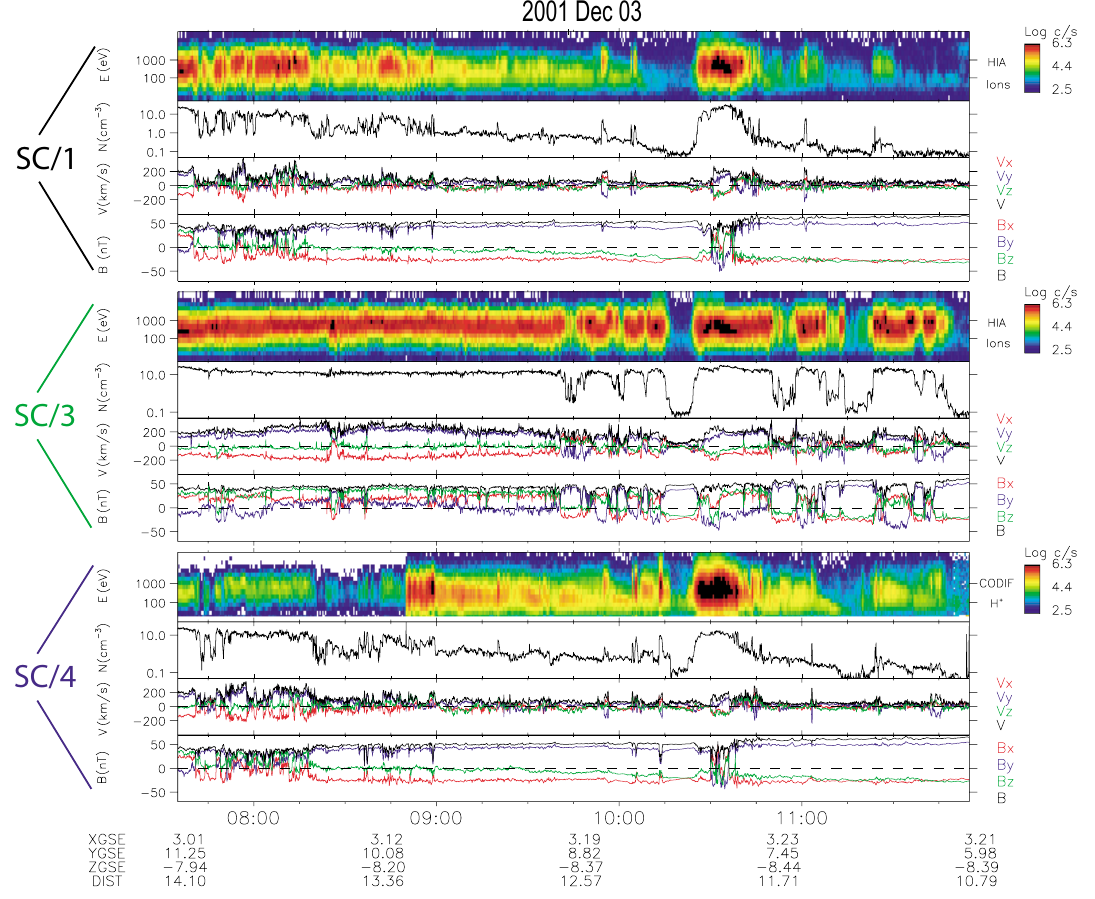
Fig. 2. Summary plot of the event from 07:35 to 11:55 UT . The four top panels show ion energy spectrogram, ion number density, ion velocity components and magnetic field components in GSE for SC/1. The following panels show the same quantities for SC/3 and SC/4,